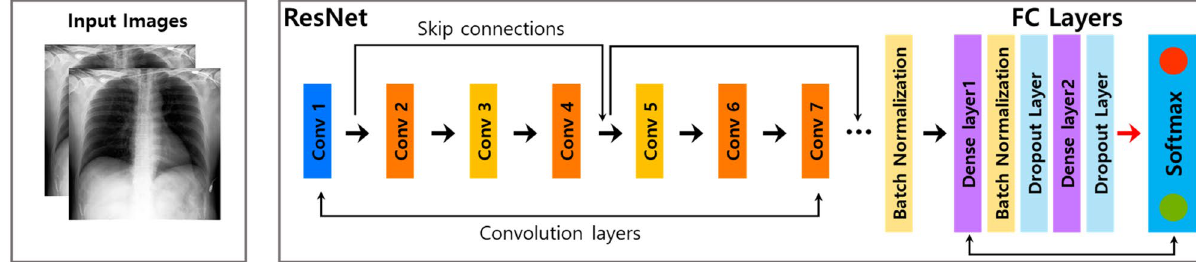
Figure 2. Model architecture of ResNet 18.